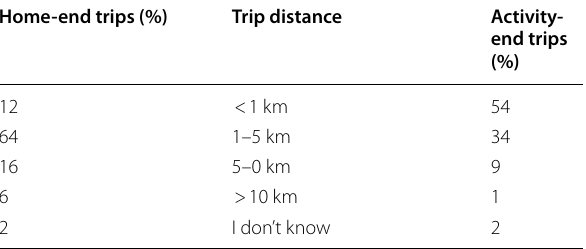
Table 2 Distance of home‑end and activity‑end trips to/from Almere